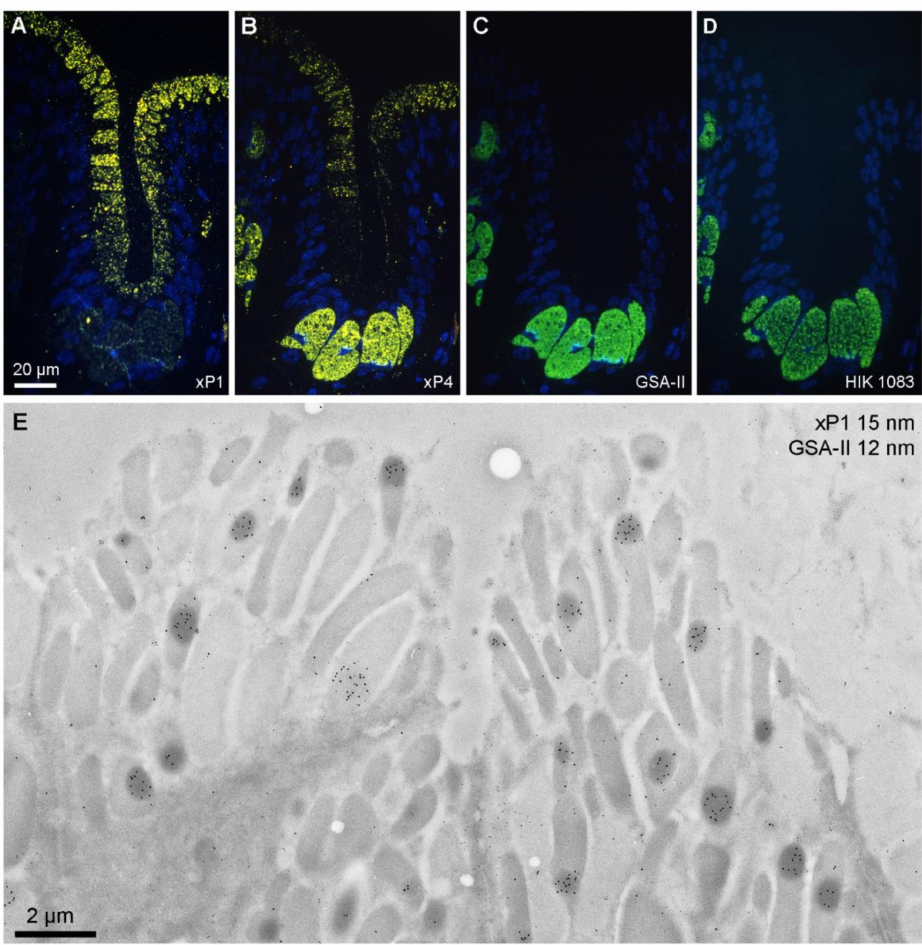
Figure 1. Labeled ultrathin methacrylate (Lowicryl K11M) sections of X. laevis stomach fundus. Fluorescence microscopy of sequential serial sections labeled for: (A) xP1 with antiserum anti-xP1-1 (Cy3, yellow); (B) xP4 with antiserum anti-xP4-1 (Cy3, yellow); (C) mucin with GSA-II (FITC, green); (D) mucin with antiserum HIK1083 (FITC, green). DNA of the cell nuclei was stained with DAPI (blue). Scale bar: 20 µ m. (E) Electron micrograph of gold labeling with the anti-xP1-1 antiserum (detected with protein A-15 nm gold particles) and mucin staining with GSA-II (12 nm gold conjugates); scale bar: 2 µ